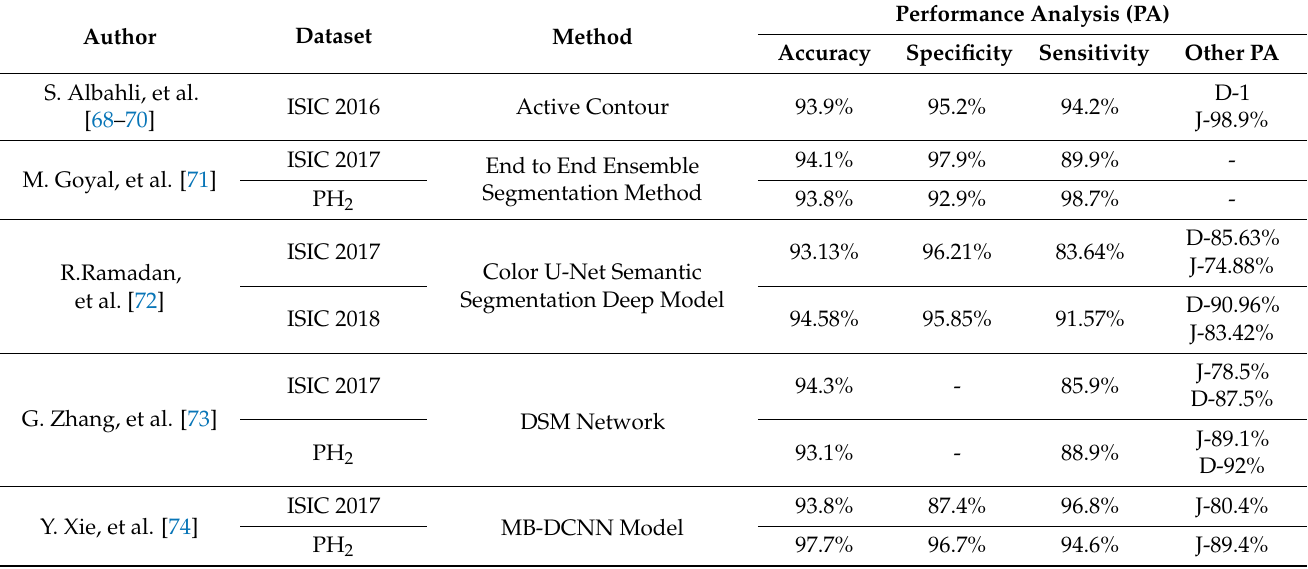
Table 4. Different soft computing-based segmentation